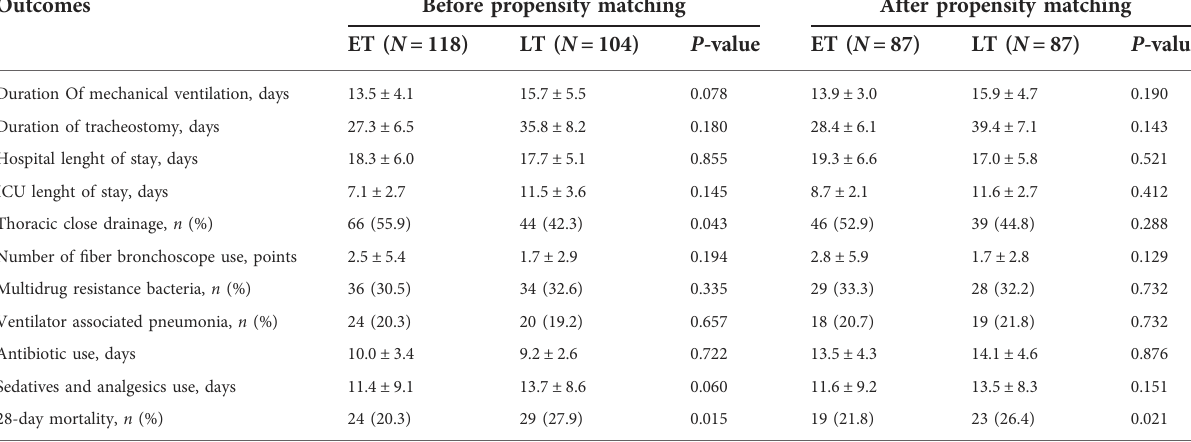
TABLE 2 Comparison of clinical outcomes of patients before and after propensity score matching. Outcomes Before propensity matching After propensity matching